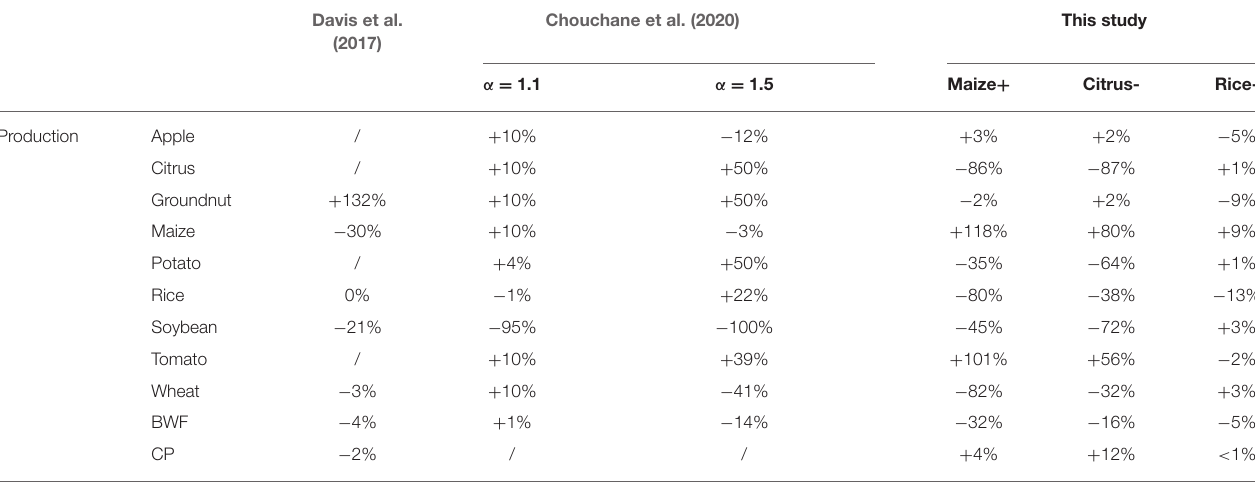
TABLE 2 | Comparison of results of previous studies and this study.